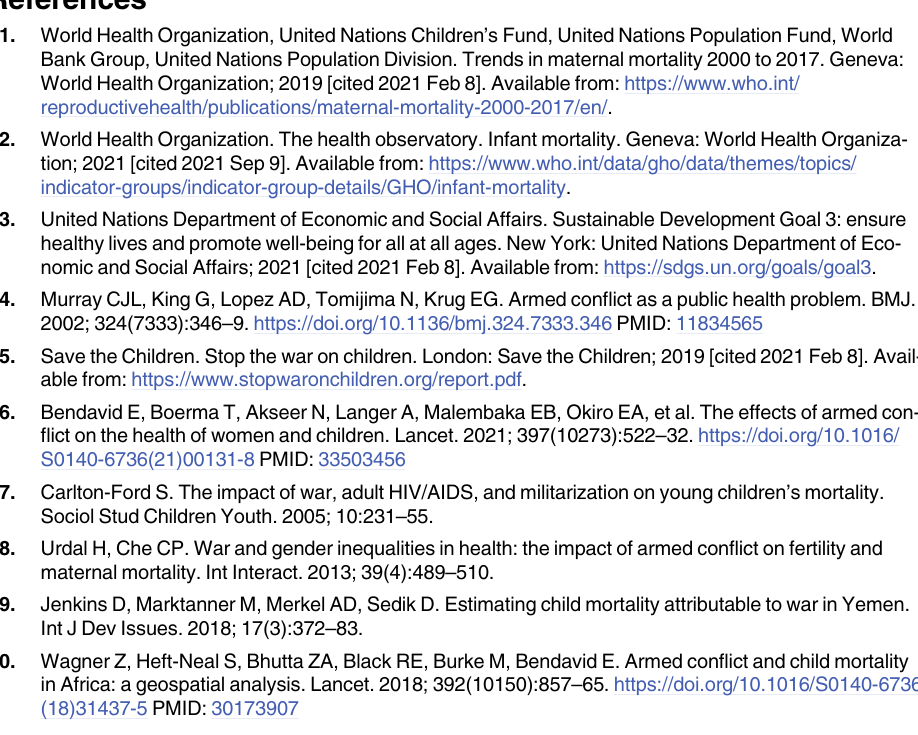
S6 Table. Sensitivity analysis: Major Episodes of Political Violence exposure data (mater- nal